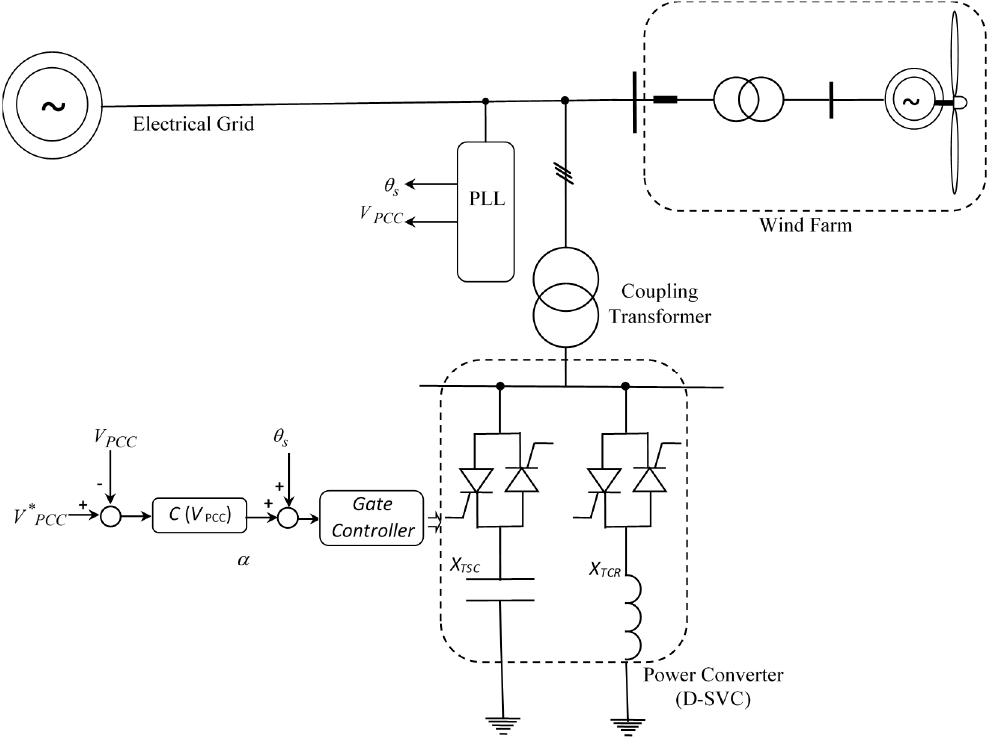
Figure 9. Control configuration of the distribution static var compensator (D-SVC) connected to the point of common coupling (PCC) with a wind farm.